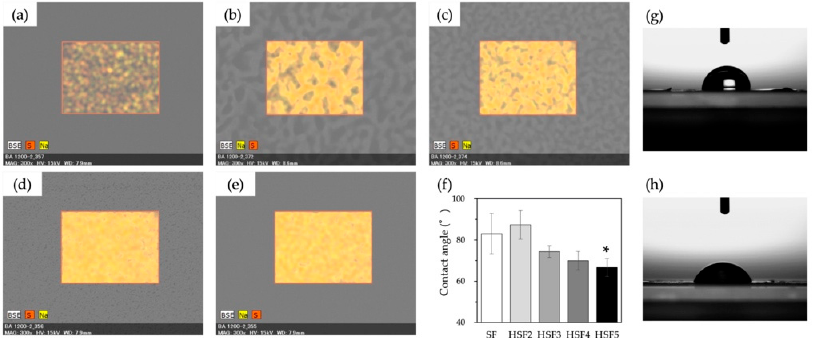
Figure 4. SEM-EDS images of the distributions of S and Na on the surface of SF ( a ), HSF2 ( b ), HSF3 ( c ), HSF4 ( d ), and HSF5 ( e ) films. ( f ) shows a water contact angle of SF and HSF samples (( g ): SF, ( h ): HSF5). * p < 0.05 relative to SF.